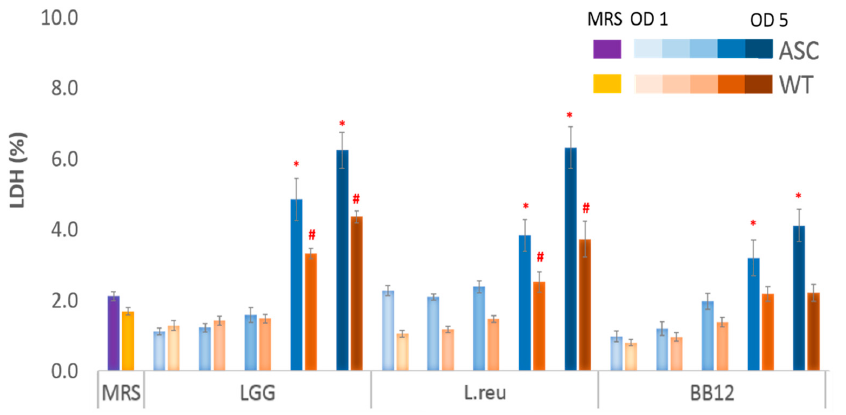
Figure 2. Effects of the postbiotics collected at OD 1 to 5 on the cell viability. The postbiotics collected from OD 1 to OD 3 did not result in cytotoxicity of the WT or ASC cells; thus, they were used in the following experiments. The postbiotics at OD 4 and 5 resulted in cytotoxicity of the WT and ASC cells, and the magnitude of cytotoxicity was higher in the ASC cells. Assays were conducted after treating the cells with postbiotics for 24 h, without LPS priming and cSiO 2 stimulation. The data are presented as mean ± SEM; the results were pooled from the biological triplicate. The bars marked with * are significantly higher than the MRS-treated ASC cells ( p < 0.05); the bars marked with # are significantly higher than the MRS-treated WT cells ( p <